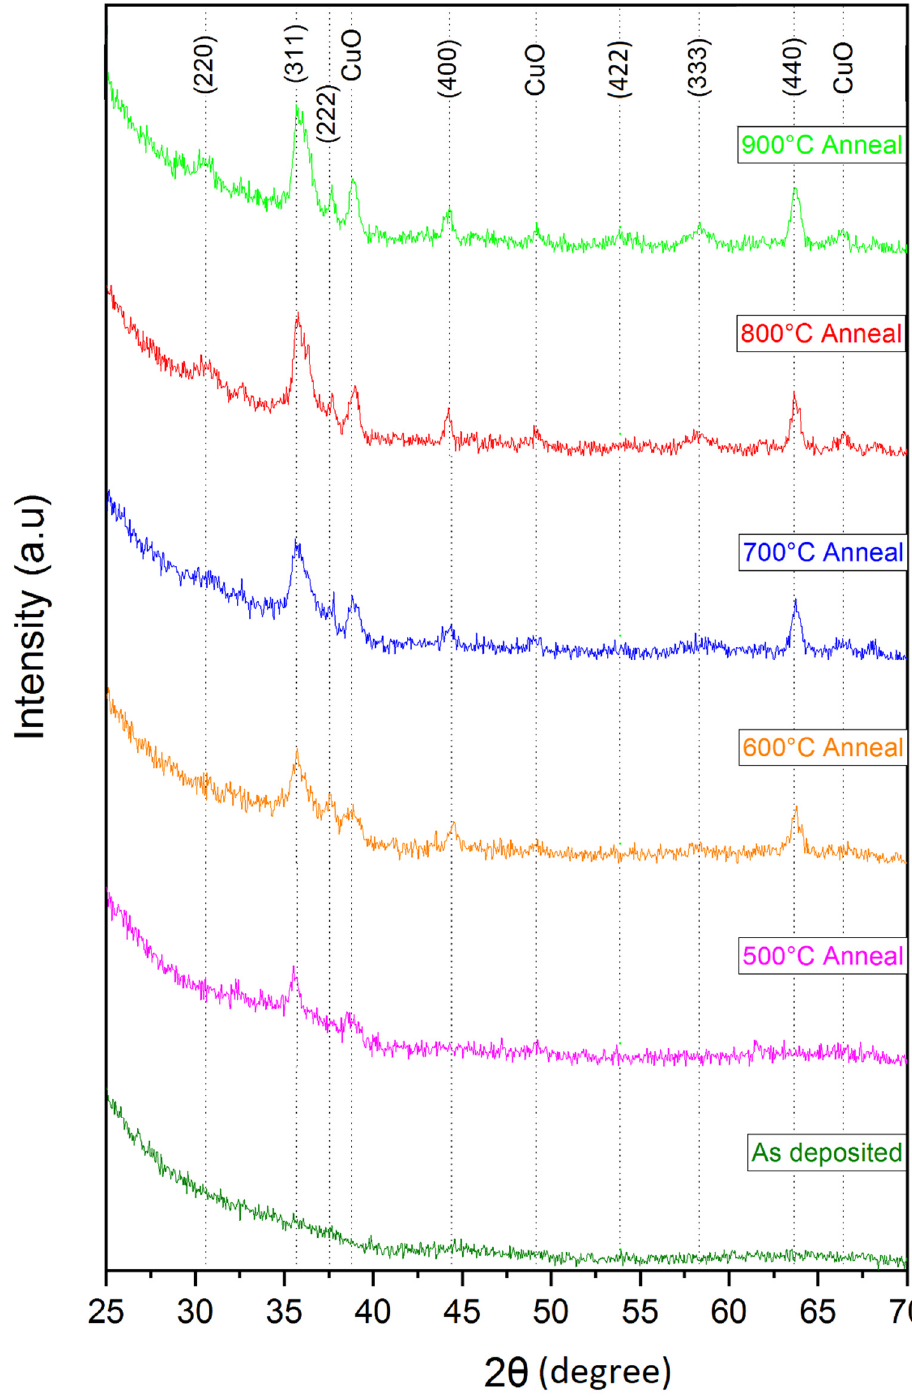
Figure 2. X-ray diffractions of the as-deposited CuGa 2 O 4 thin film and the CuGa 2 O 4 thin films annealed at 500–900 ◦ C in O 2 ambience for 1.5 h.